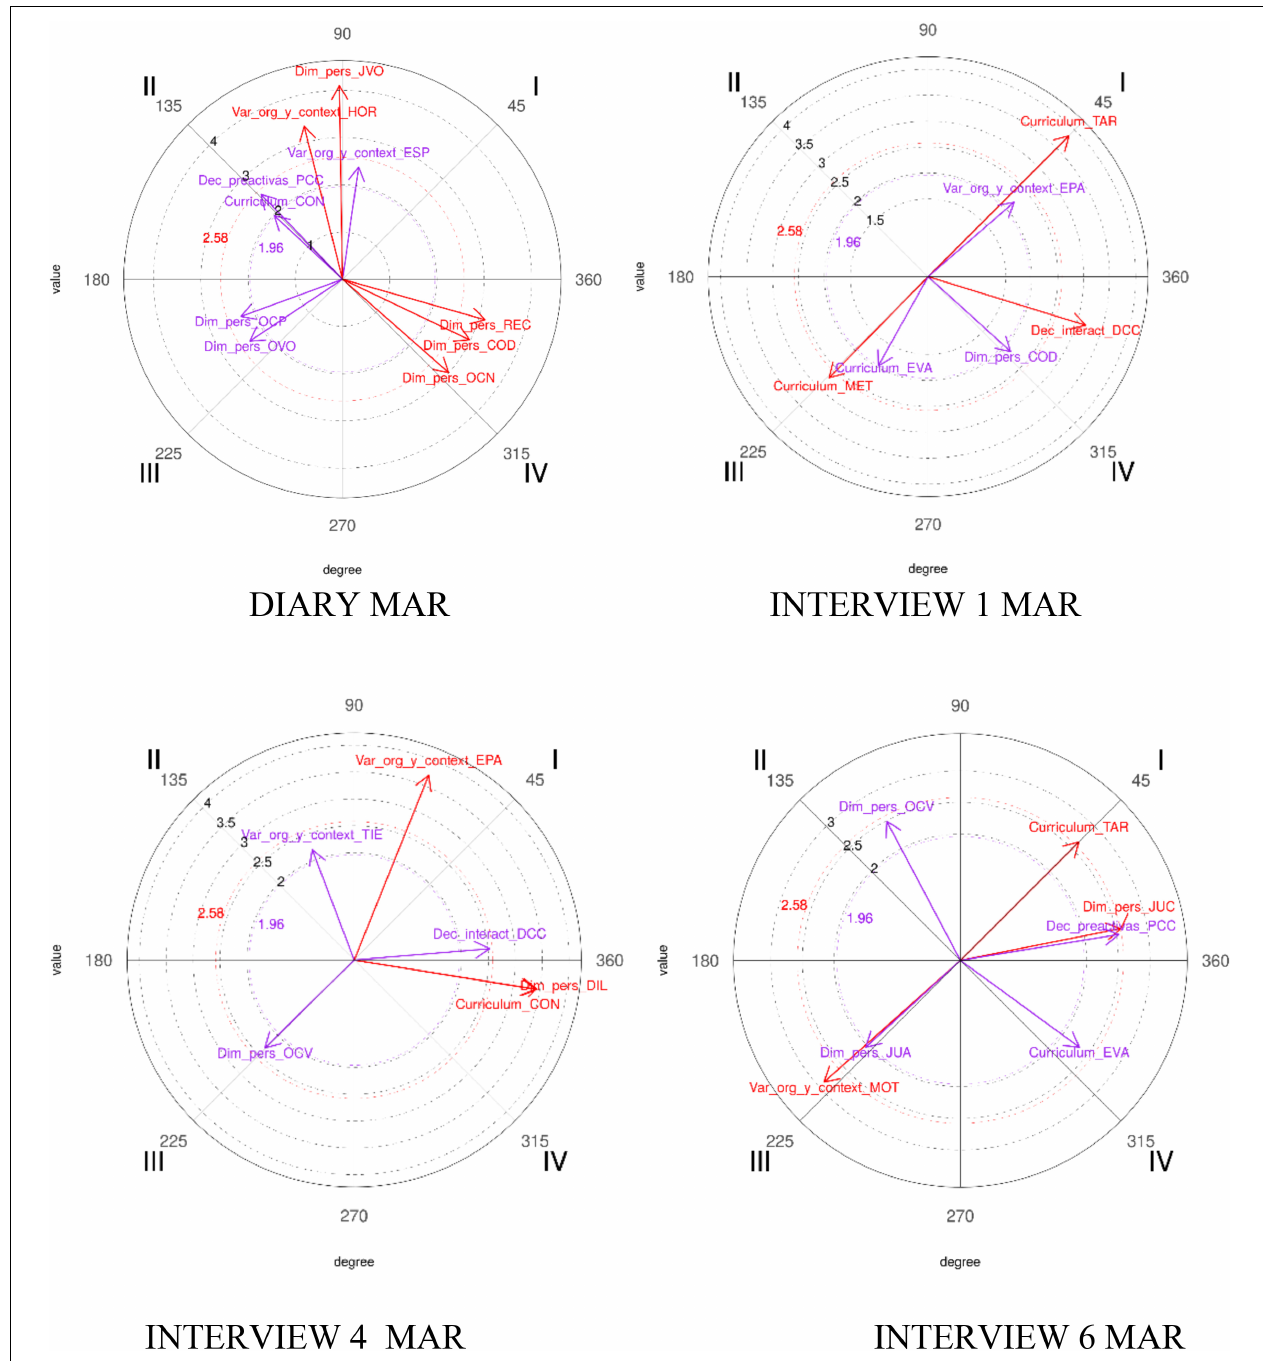
FIGURE 2 | Graphics showing the María’s relationships between focal behavior (TAR) and conditional